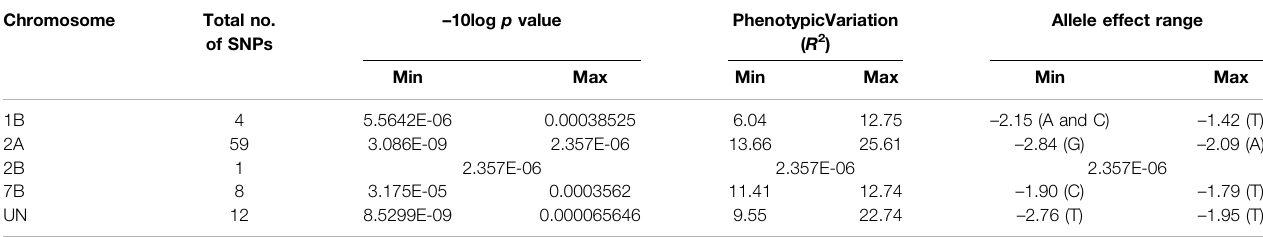
TABLE 1 | Summary of GWAS analysis for stem rust resistance including number of SNPs, range of p value, range of R 2 , and range of allele effect. – 10log p Chromosome Total no. of SNPs